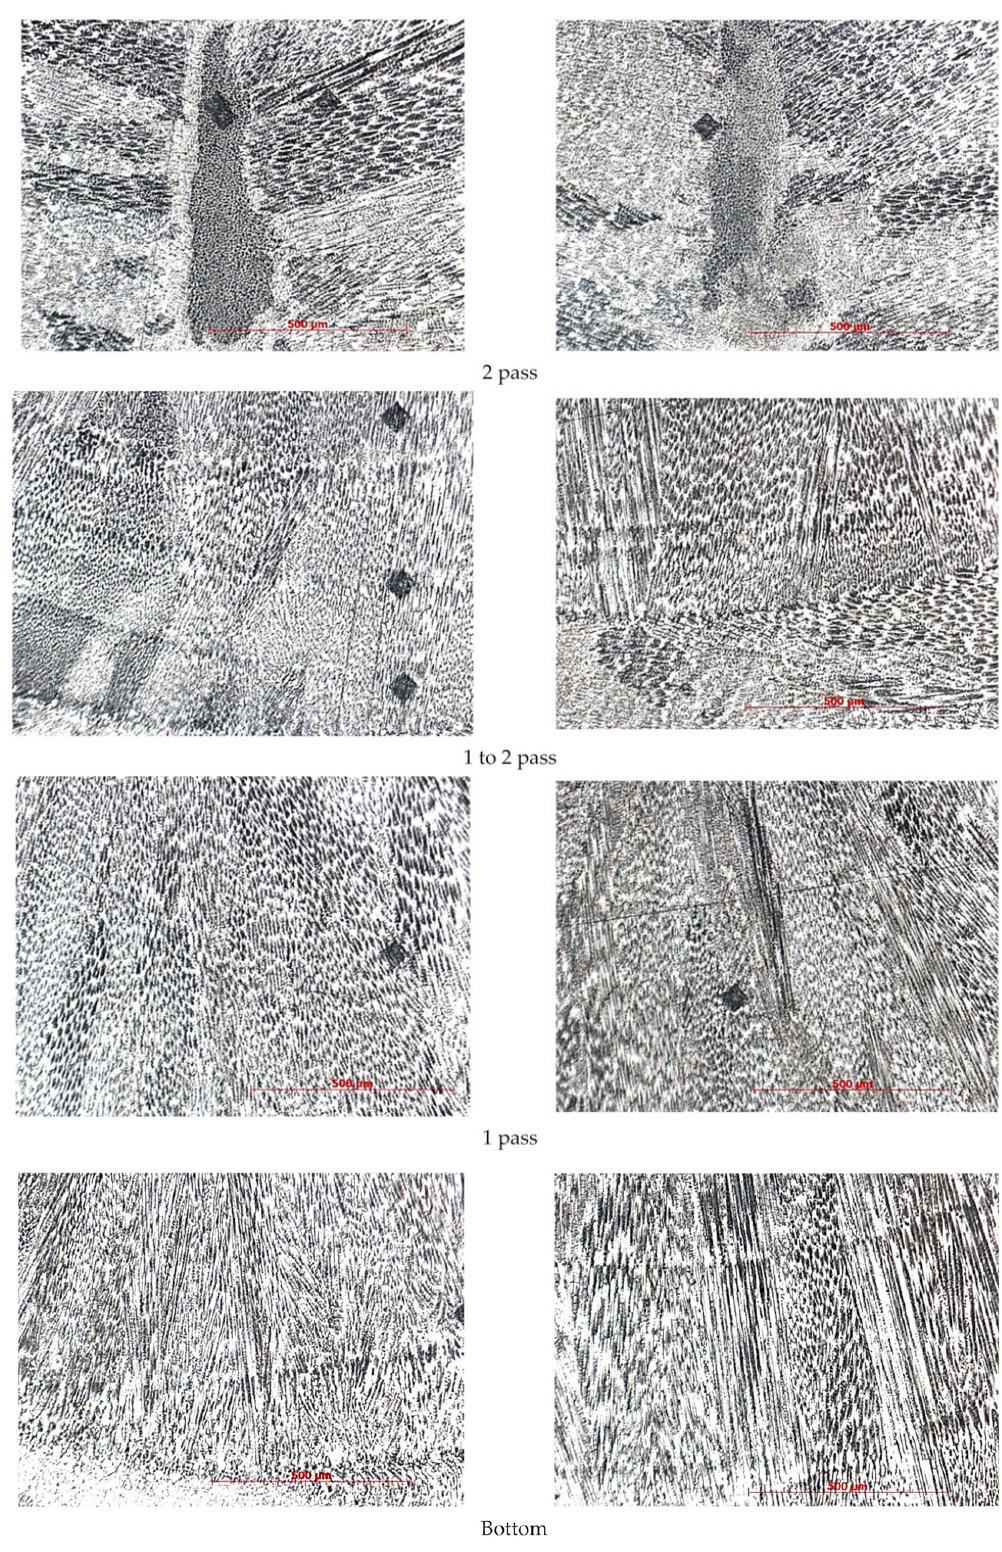
Figure 10. Microstructure of the central part of the cladded metal of different parts of the sample (bottom, first pass, transition line of first pass to second, second pass, transition line of second pass to third, third pass, and top of third pass) ×